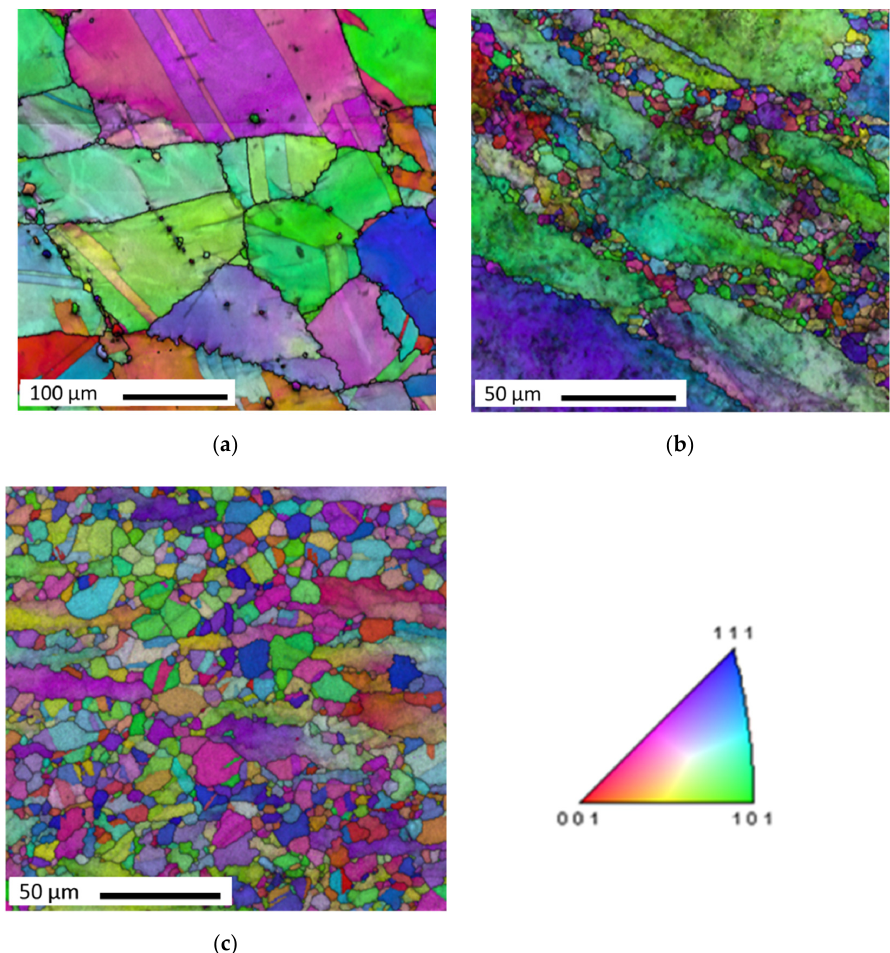
Figure 2. As-quenched microstructure of samples A, B and C. EBSD orientation maps color-coded according to the crystal direction lying parallel to the longitudinal direction (vertical), as defined in the standard triangle. ( a ) Sample A (dynamic recrystallization (DRX) volume fraction: 2%); ( b ) Sample B (DRX volume fraction: 26%); ( c ) Sample C (DRX volume fraction: 65%). Sample B (0.55 strain) has a significantly higher volume fraction of recrystallized grains, around 26%, with the typical necklace topology of small recrystallized grains around large deformed grains.